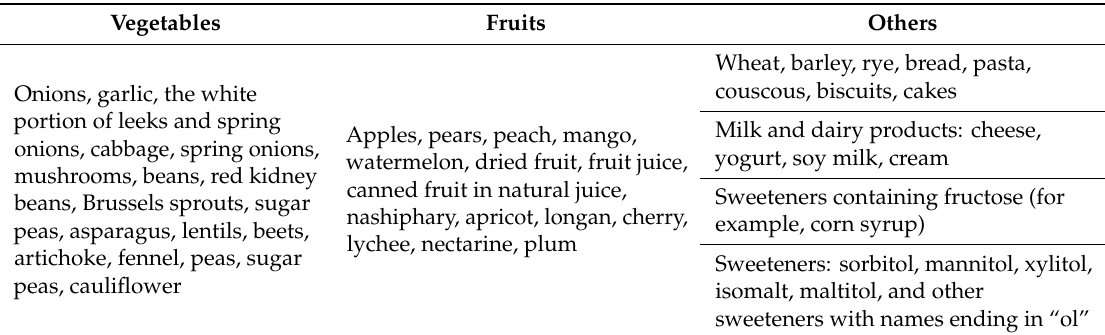
Table 2. The food items that should be avoided in a National Institute for Health and Care Excellence (NICE)-modified diet. Vegetables Fruits